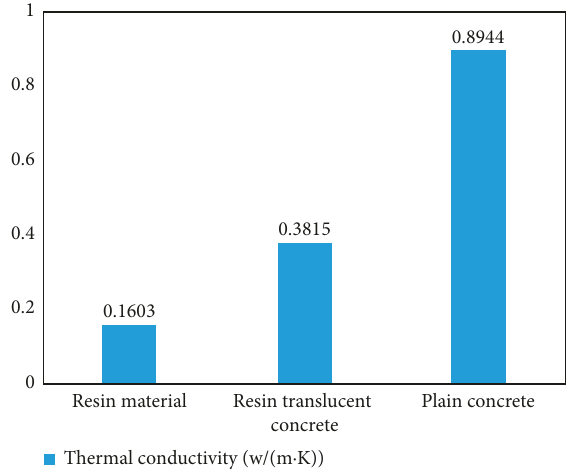
Figure 23: Thermal conductivity of specimens.